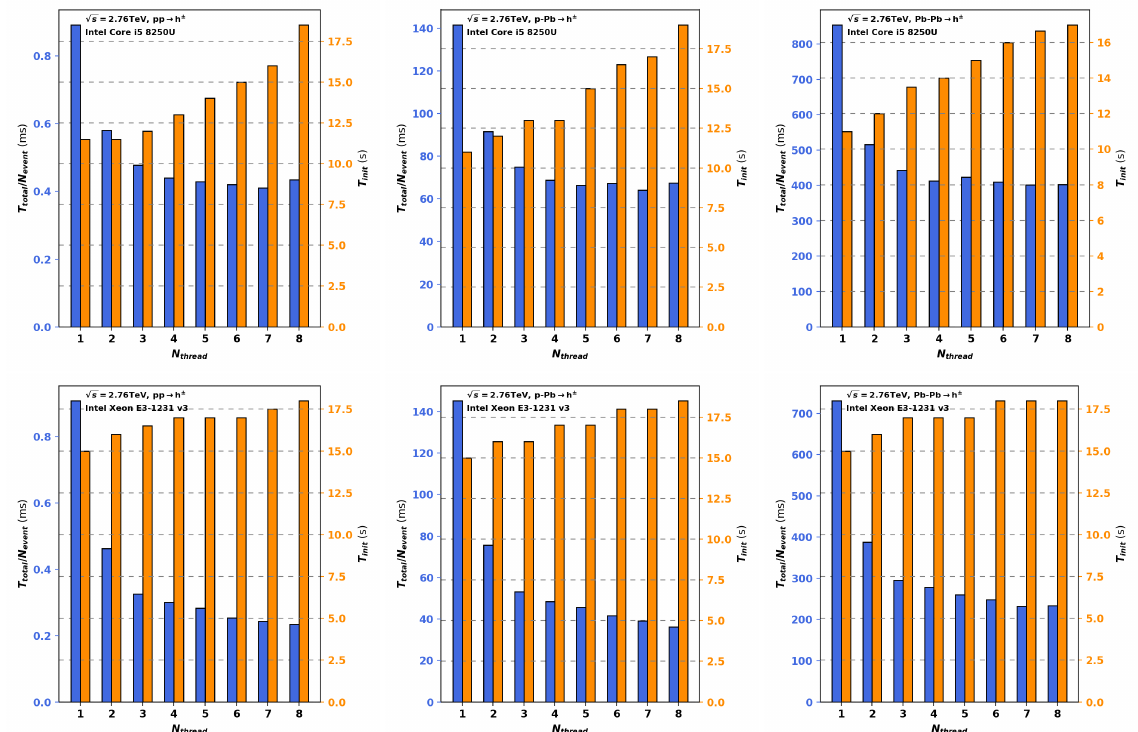
Figure 1. The total runtime normalized with the event number (blue bars) and the initialization time (orange bars) versus the CPU threads, measured on an Intel(R) Core(TM) i5-8250U CPU ( upper panels ) and on an Intel(R) Xeon(TM) E3-1231 v3 CPU ( lower panels ). The run parameters: ( left panels ), proton-lead ( middle panels ) and lead-lead collisions ( right panels ), using (nuclear) parton distribution functions CT14nlo (for protons) and EPPS16nlo_CT14nlo_Pb208 (for lead nuclei), defining 6 different histogram analysis